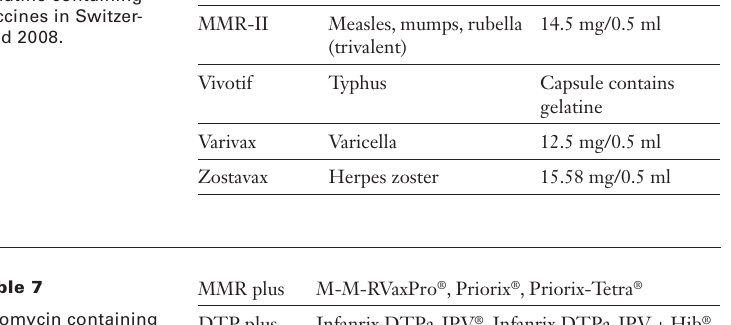
Neomycin containing vaccines in Switzerland.